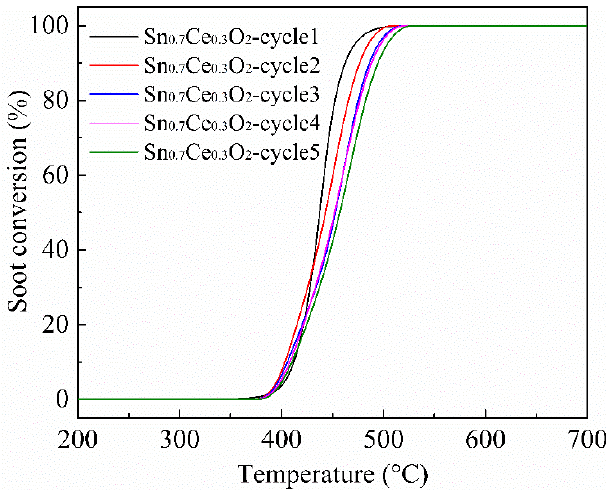
Figure 14. Cyclic TPO profiles of the Sn 0.7 Ce 0.3 O 2 fiber catalyst. Table 4. Soot combustion activity of the Sn 0.7 Ce 0.3 O 2 fiber catalyst recycling performance. Fiber